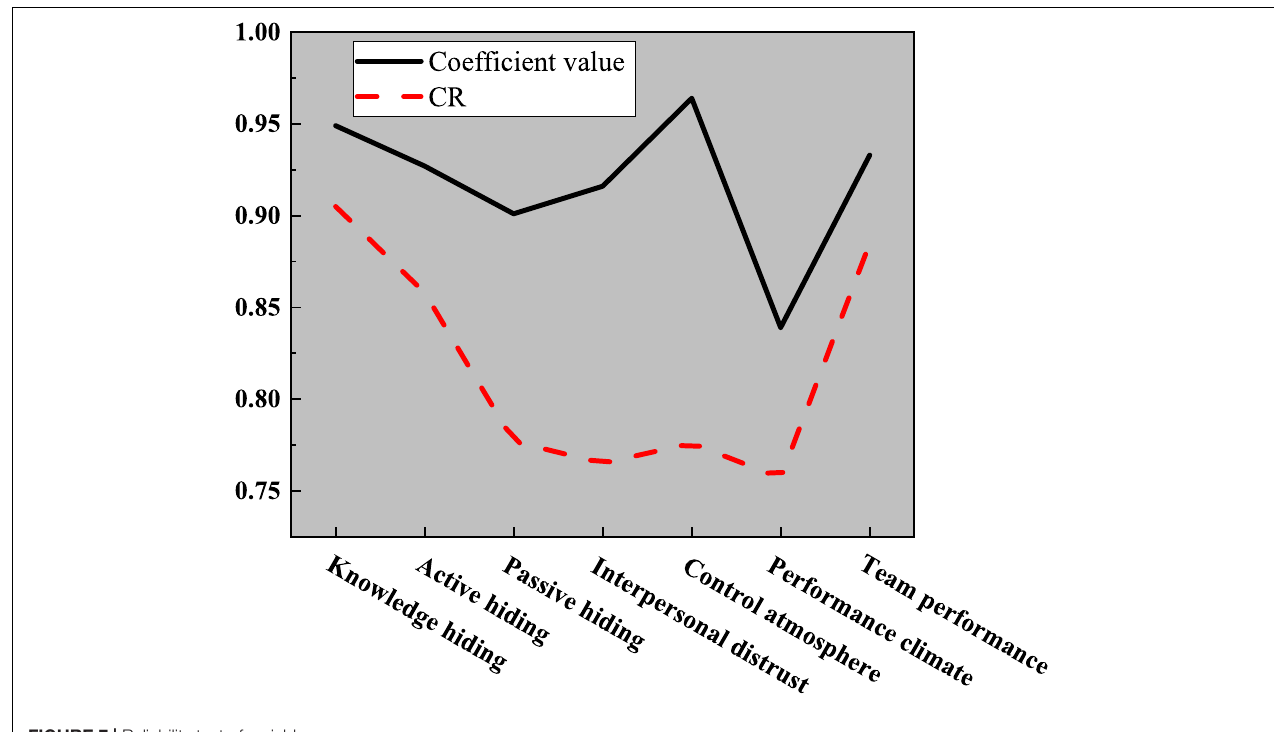
FIGURE 7 | Reliability test of